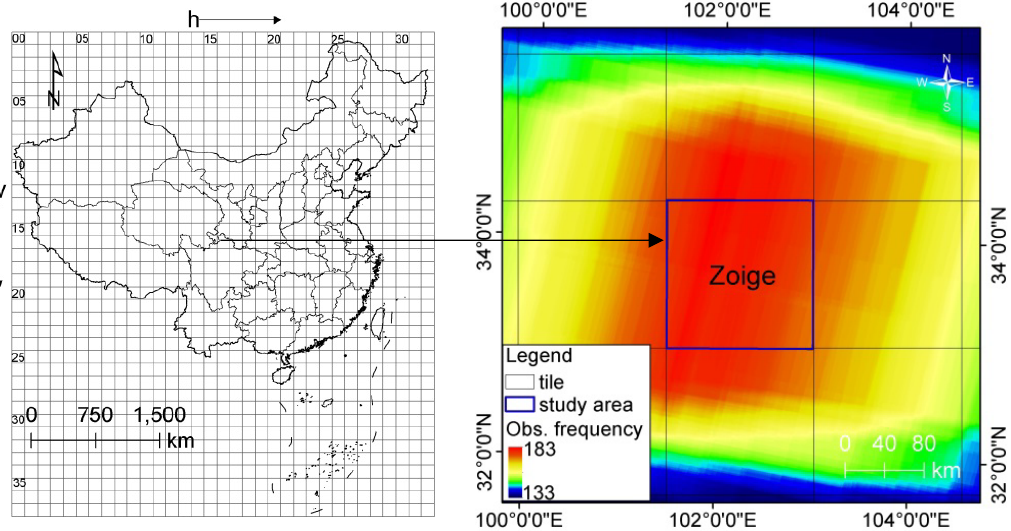
Figure 3. The tile coordinate scheme of China ( left ) and the observation frequency of HJ1-A/B for the study area in the year 2010 ( right ). The tiles are generated in this paper from the upper left coordinate of China in 150 km ˆ 150 km and are defined in the Albers Equal Area projection. The color gradient represents the observation frequency of all the HJ-1A/B imagery from paths 14–19, row